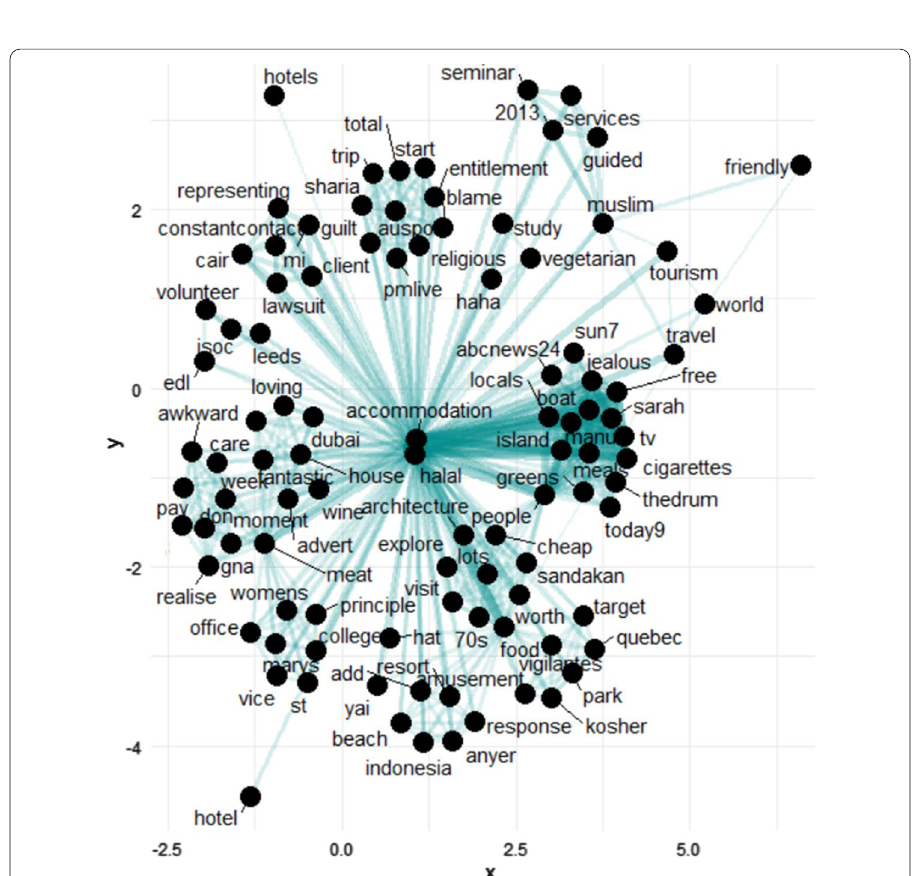
Fig. 4 Semantic network representing halal tourism